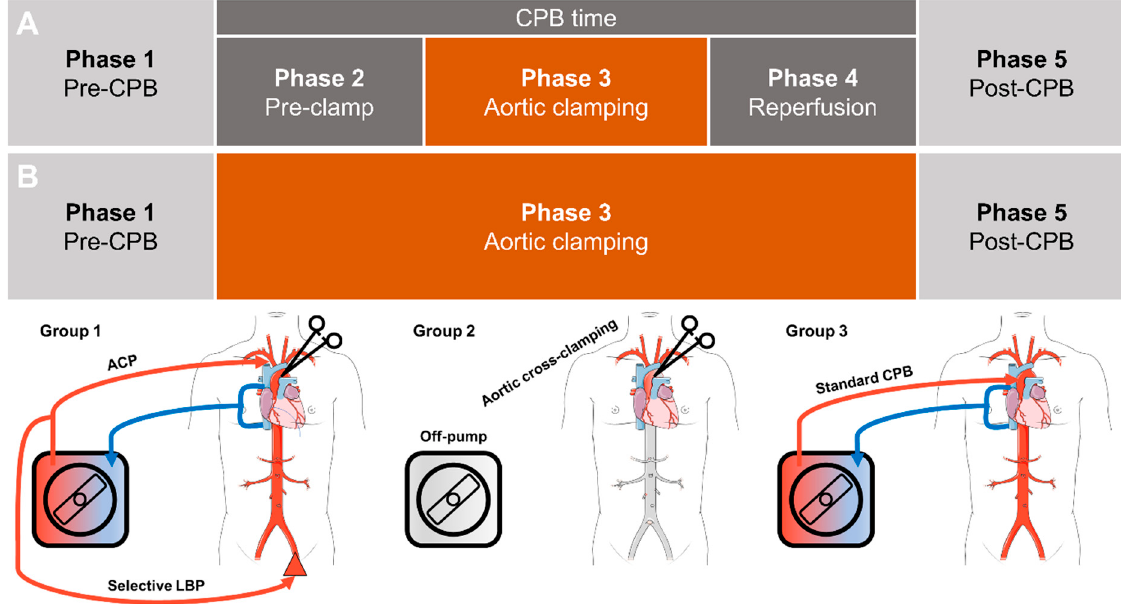
Figure 1. Time points and perfusion strategies of intraoperative tissue oxygen supply measurements. ( A ): standard cardiopulmonary bypass (patient group 3) and selective lower body perfusion (patient group 1) for aortic arch surgery are divided into five phases. ( B ): patients who underwent isolated coarctation resection (group 2) did not undergo CBP, leaving only phases 1, 3, and 5 for intraoperative measurements. ACP: antegrade cerebral perfusion; CPB: cardiopulmonary bypass; LBP: lower body perfusion.